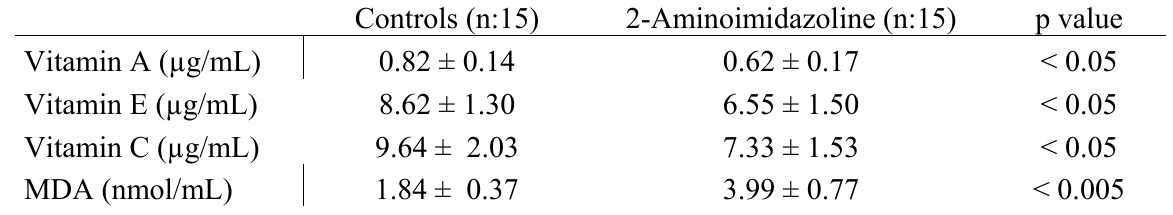
Table I. The levels of antioxidant vitamins (A, E and C) and MDA of rats which was injected with 2-Amdz and the control groups. The results are given means ±